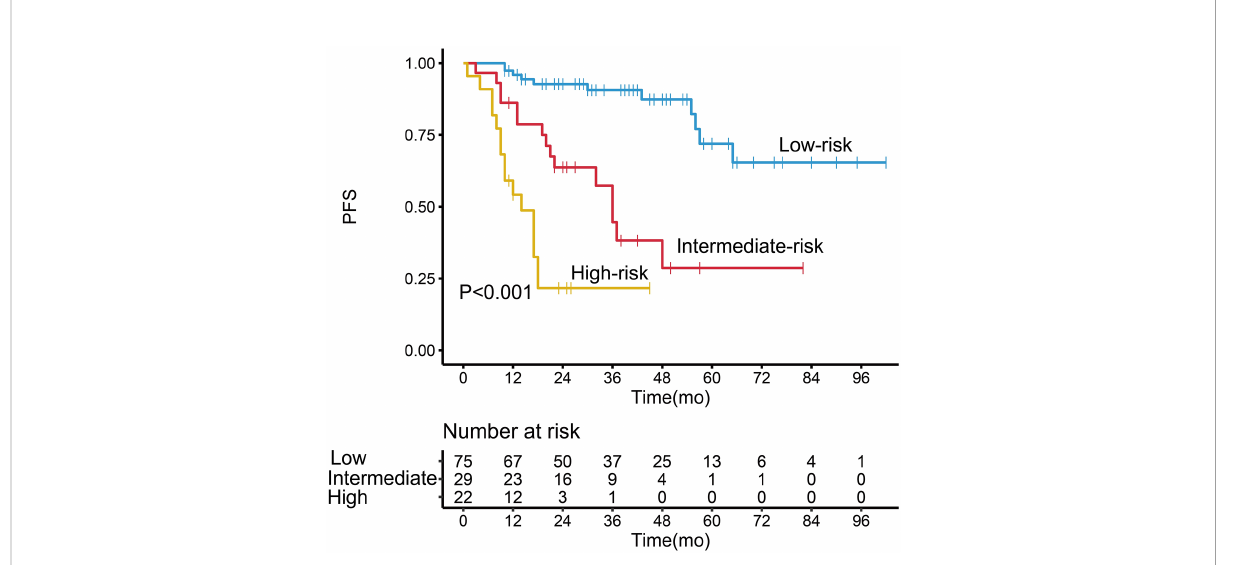
FIGURE 3 Kaplan – Meier survival analysis of progression-free survival in follicular lymphoma patients according to the potential grading